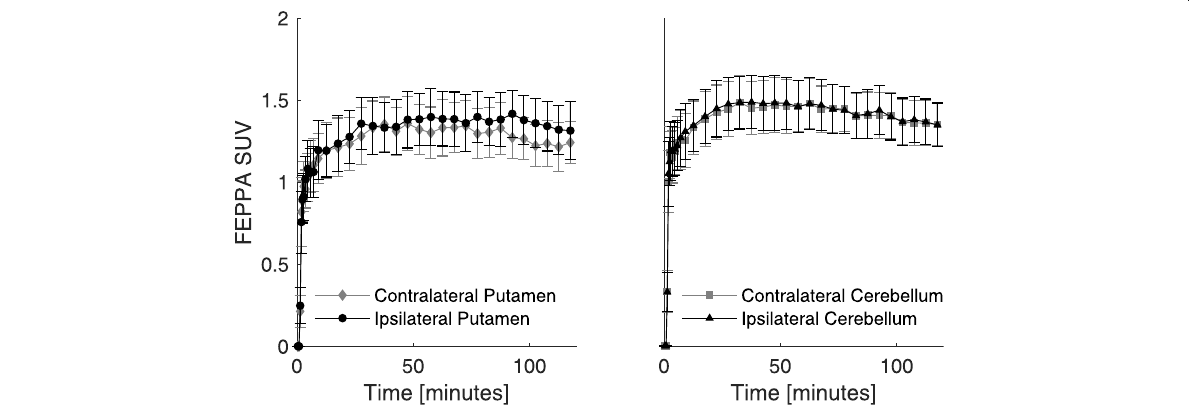
Fig. 4 Mean [ 18 F]FEPPA time-activity curves for monkeys ( n = 6) receiving allogeneic iPSC-mDA. Error bars represent the standard error of the mean (SEM). Higher uptake is observed in the graft sites with allogeneic iPSC-mDA compared to the contralateral (control) putamen